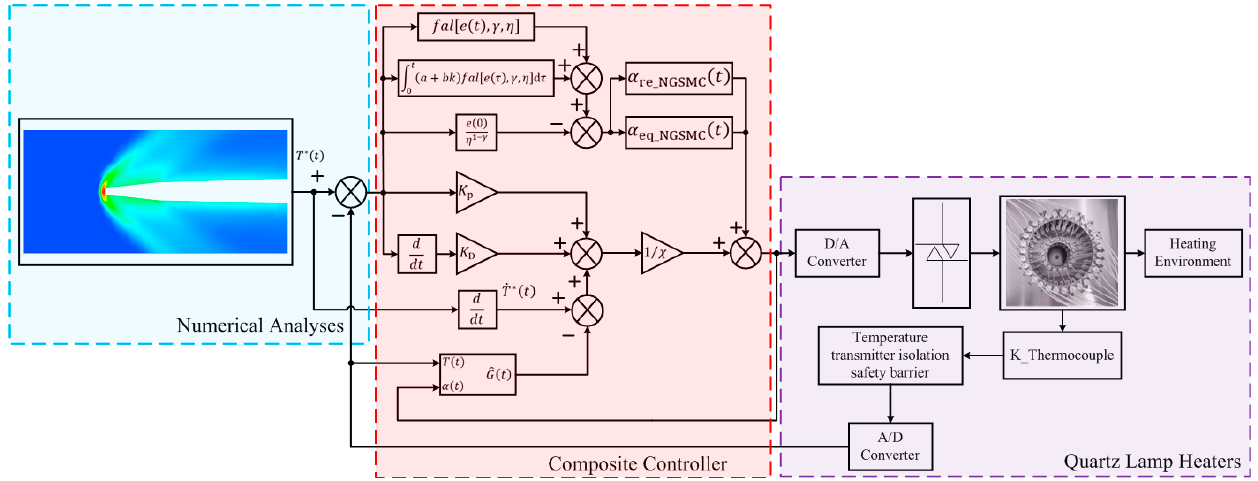
Figure 13. Schematic illustration for the composite controller.